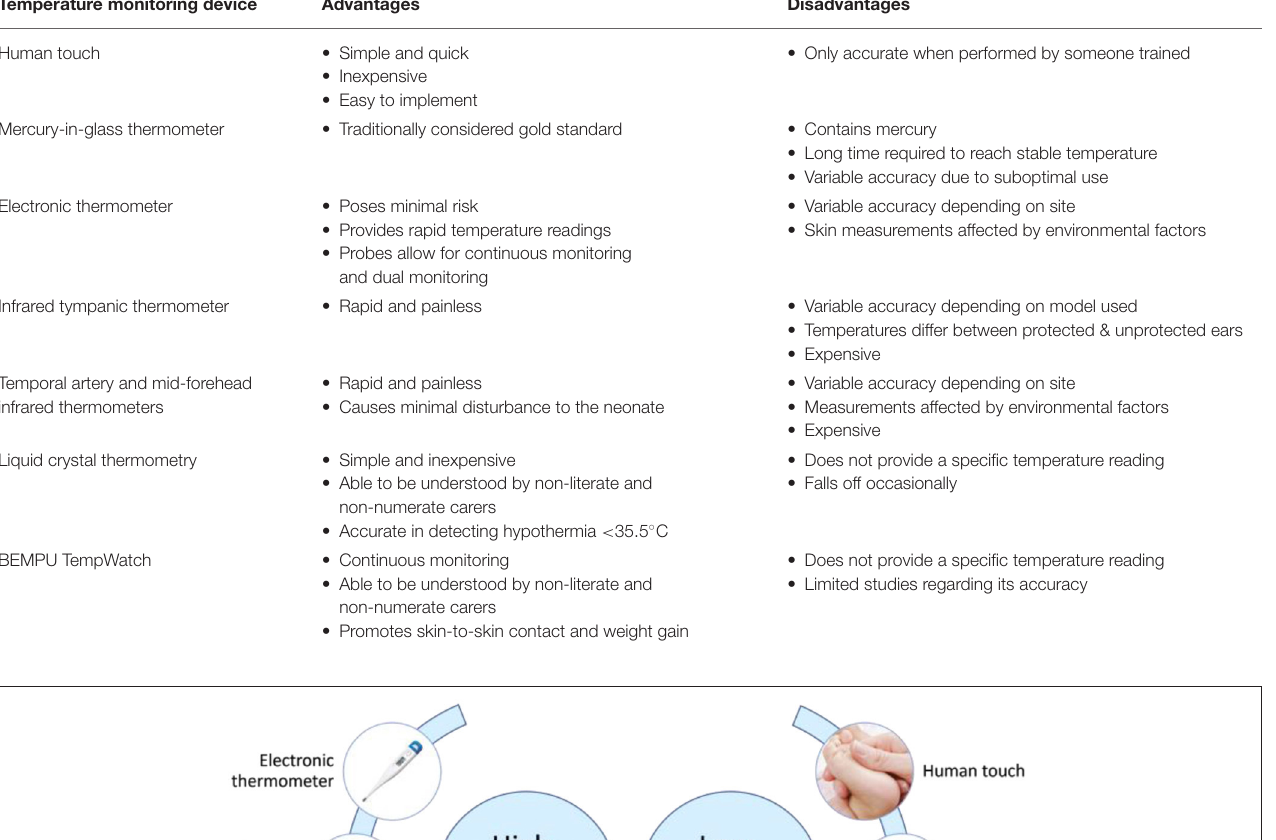
TABLE 2 | Summary of current methods of temperature monitoring and their advantages and disadvantages.